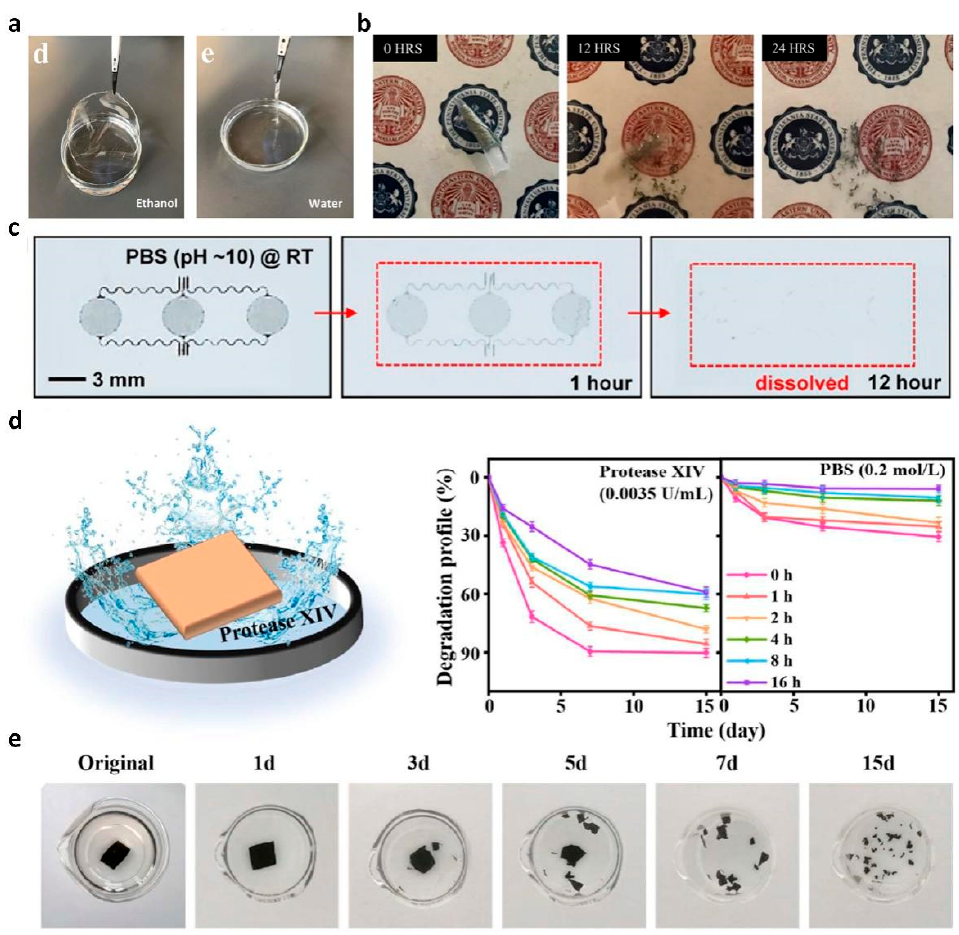
Figure 8. ( a ) Photograph of A Galactomannan film immersed in ethanol and water for 24 h; ( b ) photograph of the proposed Zn electrode immersed in ethanol and distilled water for 24 h (adapted from [122] with permission from the American Chemical Society); ( c ) photographs of the transient electrode immersed in PBS solution (PH 10) at room temperature (adapted from [123] with permission from the American Chemical Society); ( d ) schematic of the Ppy@AM-SF/CNC films immersed in protease XIV solution (left) and the weight loss change of the Ppy@AM-SF/CNC films in protease XIV solution and PBS solution (right); ( e ) photographs of the Ppy@AM-SF/CNC films immersed in protease XIV solution over 15 days (adapted from [124] with permission from the Elsevier B.V.). Table 1. Comparison of sensing properties according to fabrication technique with commercial Ag/AgCl electrodes. Materials